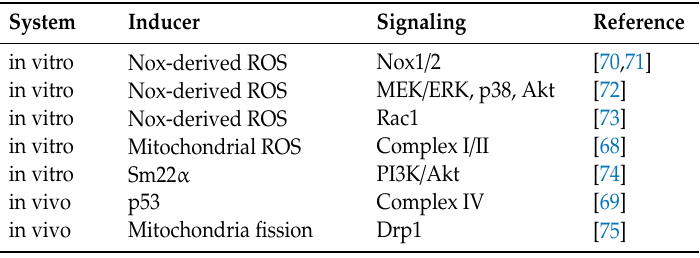
Table 1. Mediators of AngII-dependent senescence in VSMC.